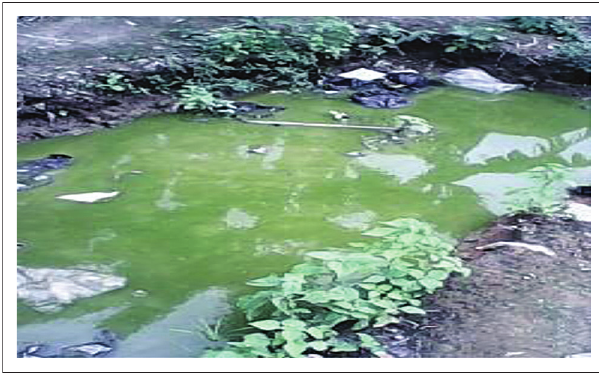
FIGURE 3: Stagnant water in a puddle at Kansawurodo after